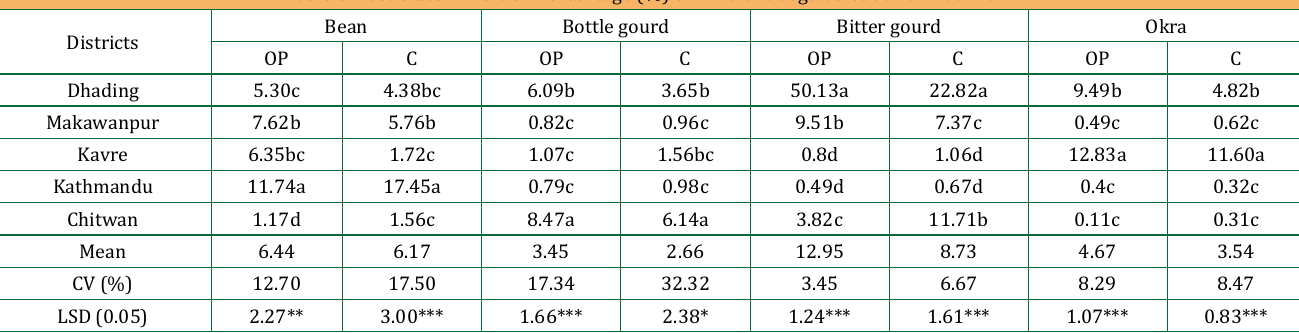
Table 3: Pesticides Inhibition Percentage (%) of Different Vegetables at Kalimati Mark